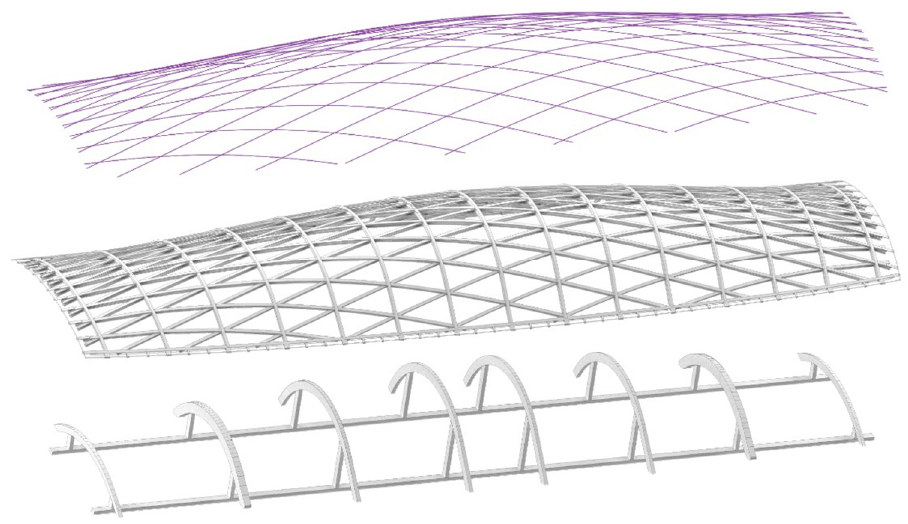
Figure 25. Selected grid solution and 3D model of the gridshell and formwork.